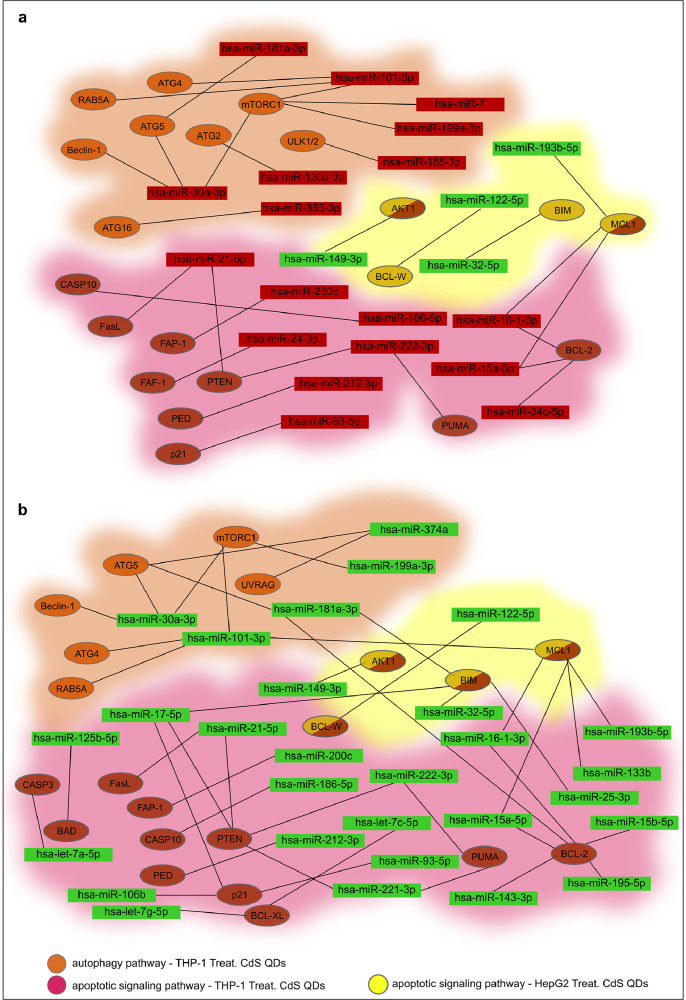
Network analysis of the microRNome in HepG2 and THP-1 cells treated with CdS QDs. The interaction network was obtained from the individual networks of HepG2 and THP-1 cells but considers only the autophagy and apoptotic processes and disregards all the others derived from the GO analysis. In HepG2 cells treated with 2.3 µg ml−1 Cd as CdS QDs, the apoptotic pathway is triggered because there are miRNAs which normally involved in its repression (in yellow) which are down-regulated (in green). a, In THP-1 cells treated with 5 µg ml−1 Cd as CdS QDs, the apoptotic pathway is hindered by the induction of different miRNAs (in red) which have an inhibitory effect on apoptotic genes (in brown). In the same cell type, autophagy is blocked because the induced miRNAs (in red) had an inhibitory effect on genes (in yellow) which inhibit autophagy at various stages.b, In THP-1 cells, treated with 39 µg ml−1 Cd as CdS QDs, the apoptotic pathway is hindered by the decrease of different miRNAs (in green) which target pro-survival genes (in brown). In the same cell type, autophagy is triggered because the decreased miRNAs (in green) reduce the inhibitory effect on the target genes (in ochre) involved in the process.Note: miRTargetLink software was used to obtain the data to create this interaction network.